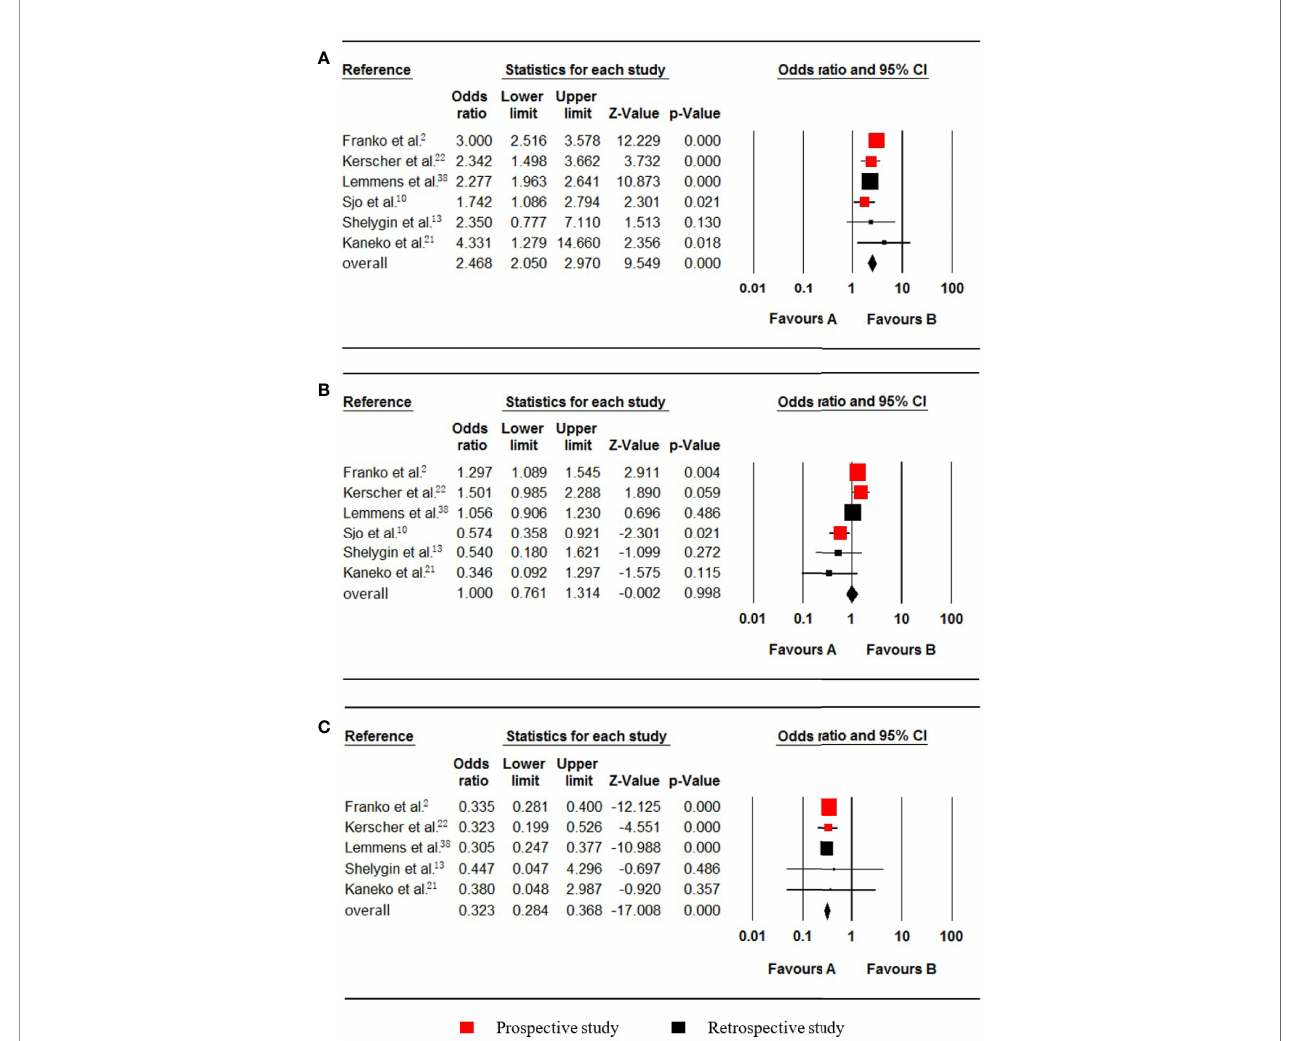
FIGURE 3 | Forest plot for the right colon, left colon and rectum locations. Favours A, non-pmCRC. Favours B, synchronous pmCRC. (A) right colon. (B) left colon. (C)